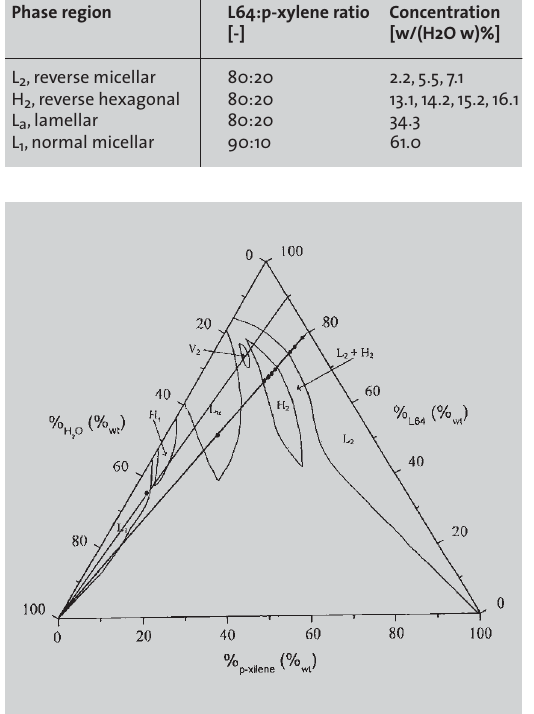
~ 90:10 and the water final con-